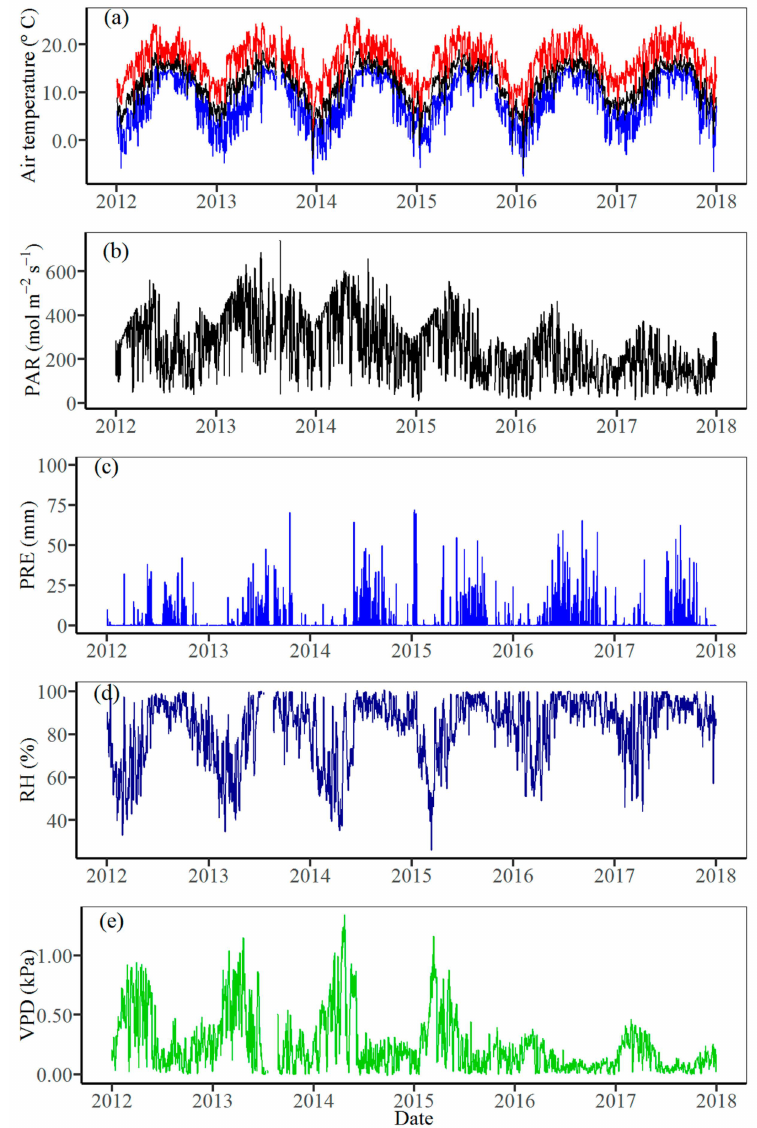
Figure 1. Daily climate conditions from the Ailao meteorological station for the period of January 2012 to December 2017: ( a ) daily minimum (blue), mean (black), and maximum (red) temperature; ( b ) photosynthetic active radiation (PAR); ( c ) precipitation (PRE); ( d ) relative humidity (RH); ( e ) vapor pressure deficit